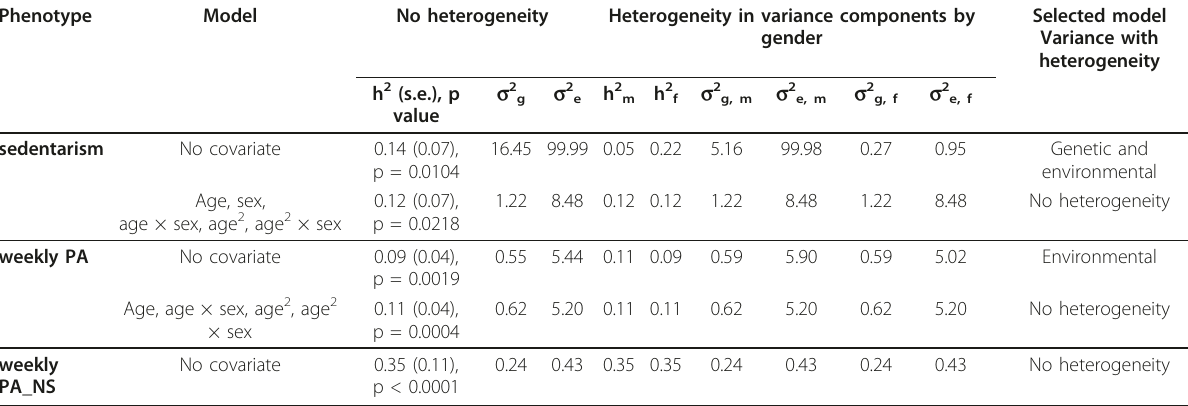
Table 4 Parameter estimates for the sedentarism, weekly PA, and weekly PA_NS phenotypes in the Brazilian families Phenotype